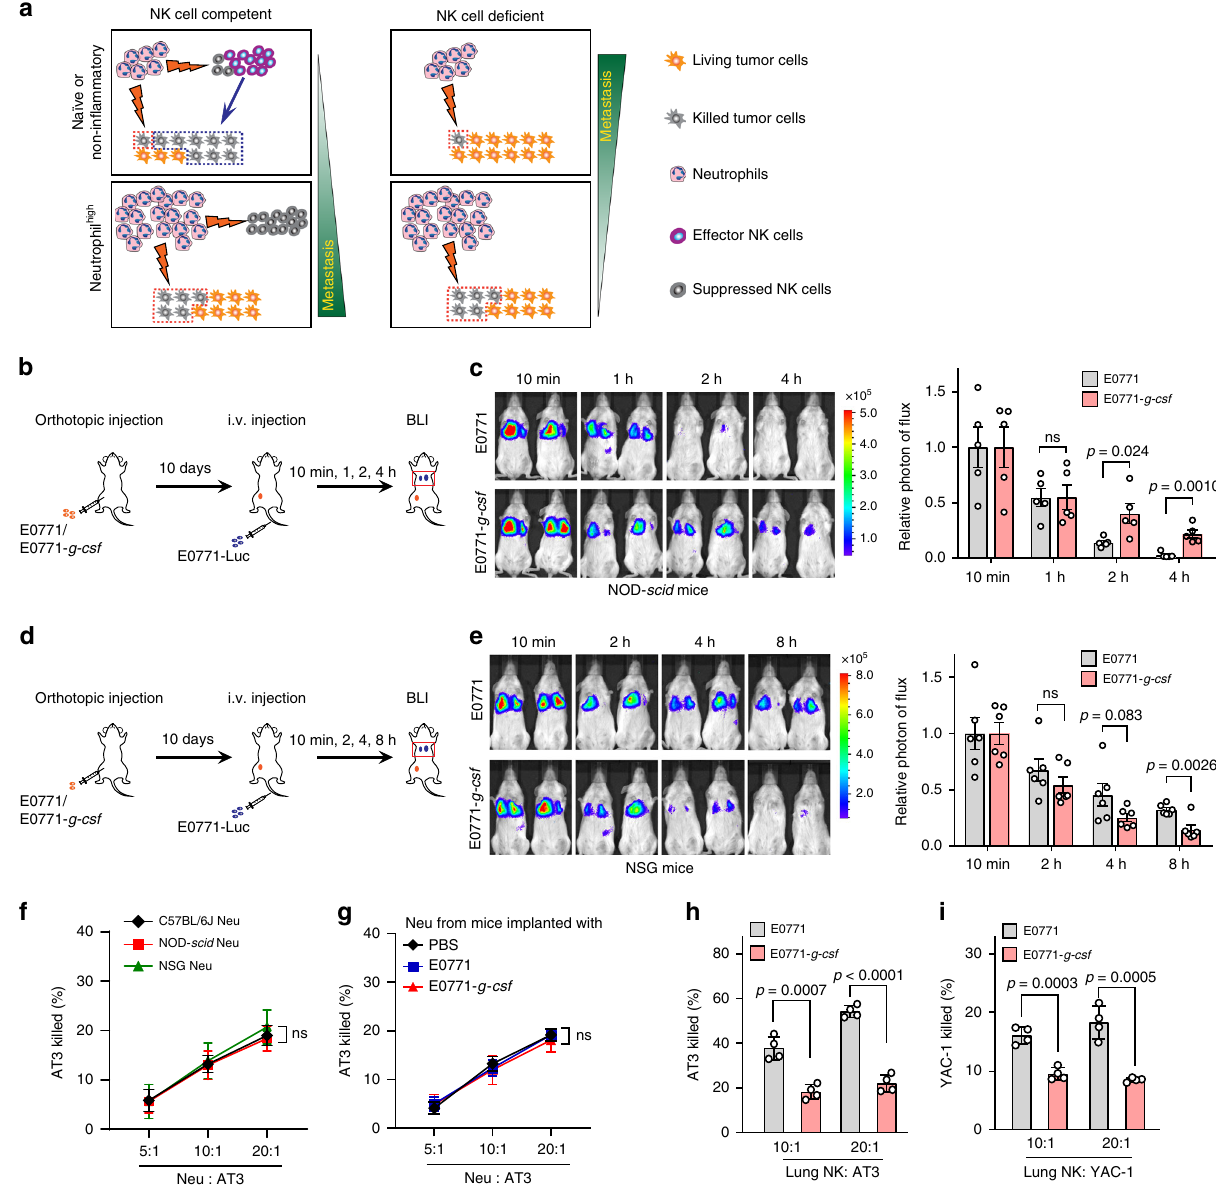
Fig. 3 The metastasis-modulating effects by neutrophils occur at the early stage of metastatic colonization. a Model depicting the dual roles of neutrophils in metastatic colonization. In the absence of NK cells, neutrophils exclusively exert their tumoricidal effect thereby showing a net anti- metastatic effect; in the presence of NK cells, neutrophils are also tumoricidal but they suppress the more tumoricidal NK cells leading to a net pro- metastatic effect. b – e Determination of neutrophilia-induced metastasis regulation at the early stage of colonization. The diagrams in b , d show the experimental designs in c , e , respectively. The representative BLI images (left), and quanti fi cation of photon fl ux (right) in each group at various time points are shown in c , e . n = 5 NOD- scid mice in c and 6 NSG mice in e per group. P values were determined by unpaired two-tailed t -test. f Comparison of the tumoricidal activities of neutrophils isolated from C57BL/6J, NOD- scid and NSG mice. Lung-in fi ltrating neutrophils were freshly isolated from E0771- g-csf tumor-bearing mice for ex vivo cytotoxic assay against AT3 cells. Statistical signi fi cance was determined by two-way ANOVA. Neu: neutrophils. g – i The tumoricidal capacities of neutrophils and NK cells under non-in fl ammatory and neutrophil high in fl ammatory conditions. E0771 cells and E0771- g-csf cells were orthotopically implanted in NOD- scid mice to induce non-in fl ammatory and in fl ammatory tumor-bearing host conditions, respectively, with PBS injection as a control. The mice were sacri fi ced at the pre-metastatic stage (day 10), and lung-in fi ltrating neutrophils were isolated for the ex vivo cytotoxic assay against AT3 cells ( g ). Statistical signi fi cance was determined by two-way ANOVA. Lung-in fi ltrating NK cells were also isolated from the same mice for the ex vivo cytotoxicity assay against AT3 ( h ) or YAC-1 cells ( i ). P values were determined by unpaired two-tailed t -test ( h , i ). Data are represented as mean ± SEM ( c , e ) or mean ± SD of four biologically independent cell cultures ( f – i ). ns not signi fi cant. Source data are provided as a Source data fi